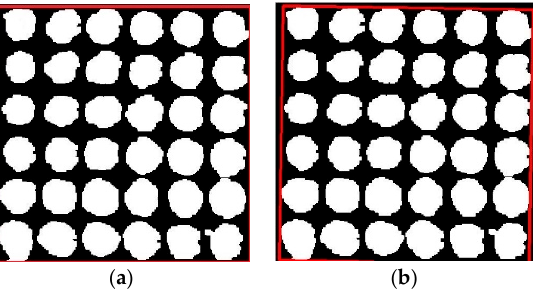
Figure 3. MBR extraction process. ( a ) initial external rectangle; ( b ) minimum bounding rectangle.